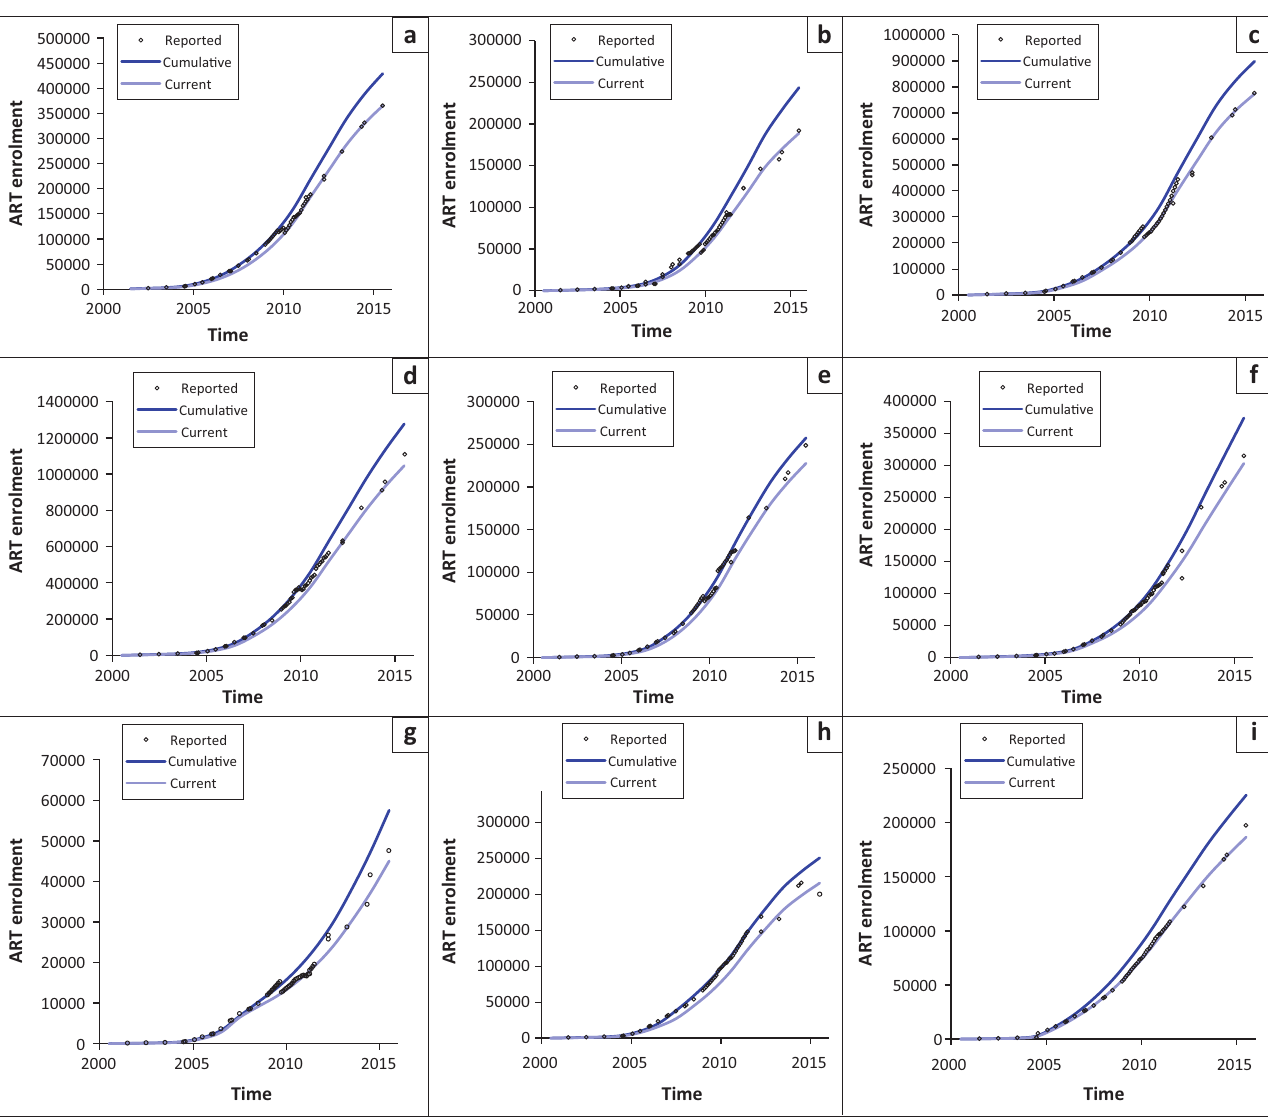
FIGURE 1: Calibration of model to reported numbers of public sector antiretroviral treatment patients, by province: (a) Eastern Cape; (b) Free State; (c) Gauteng; (d) KwaZulu-Natal; (e) Limpopo; (f) Mpumalanga; (g) Northern Cape; (h) North West; (i) Western